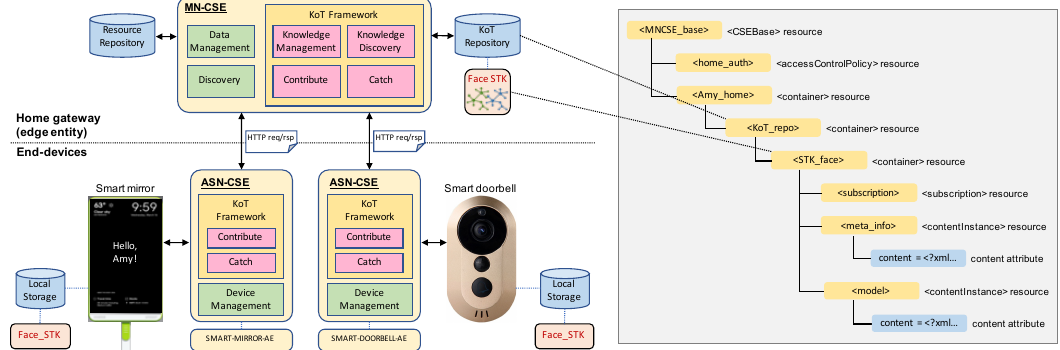
Figure 6. Smart home system design with the smart mirror and the smart doorbell, including oneM2M entities, the KoT framework, and the resource tree of the face STK. (Reproduced from [8] with permission of